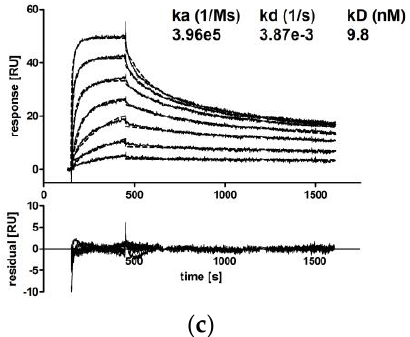
Figure 5. Kinetic analysis of CM IgA2 monomers, CM IgA2J dimers and CM IgG binding to recombinant EGFR. EGFR was immobilized on one flow cell of a CM5 chip, and a second flow cell served as a reference. Varying concentrations of CM IgA2 monomers ( a ), CM IgA2J dimers ( b ) or CM IgG ( c ) were injected at a flow rate of 50 μL/min for a 5 min association time and followed by a 17 min dissociation time. The difference between the flow cell with immobilized EGFR and the reference flow cell (solid lines) and fits (dotted lines) were plotted. Absolute residuals between data and fits are shown below. One out of two (IgA2 monomers and IgG) independent experiments is shown.